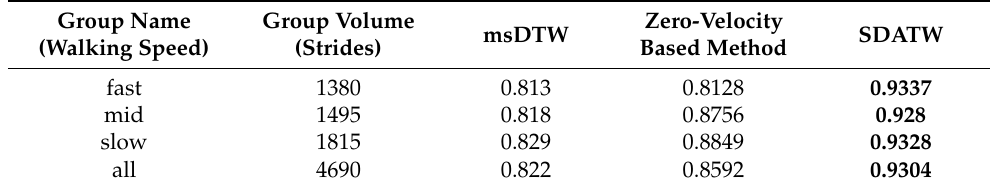
Table 3. Stride detection results for msDTW, zero-velocity based method, and SDATW in F-measure values. Best results for each speed group are highlighted in bold